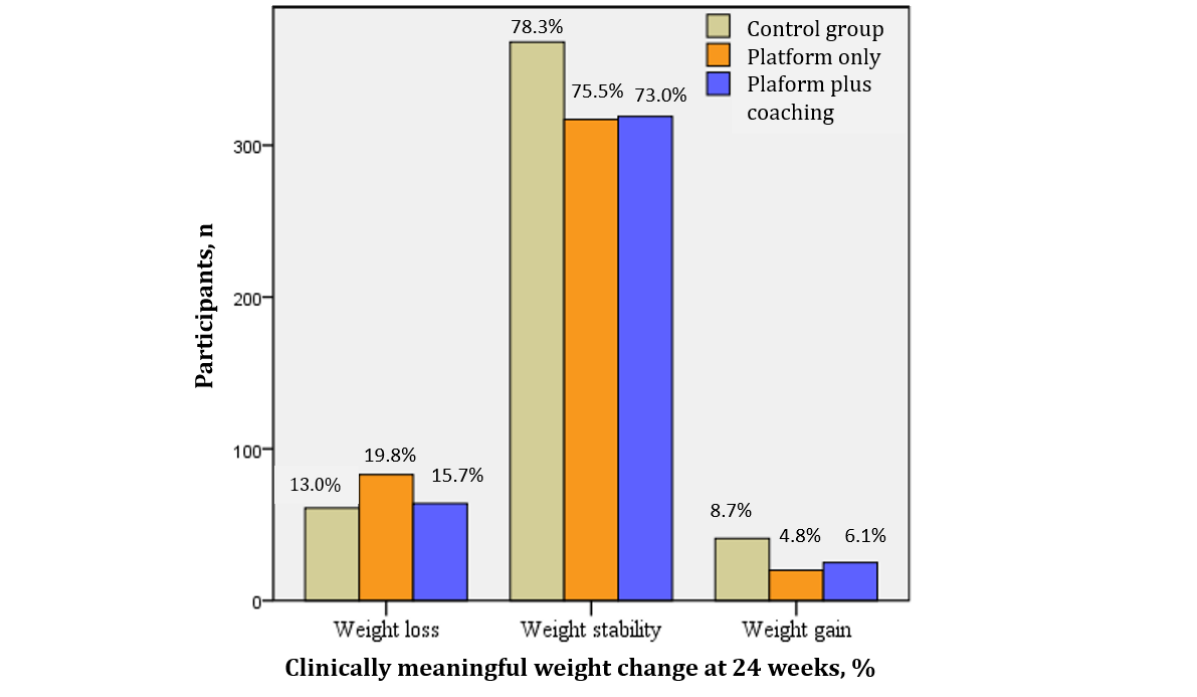
Figure 2. Clinically meaningful weight loss, stability, and gain per group at 24